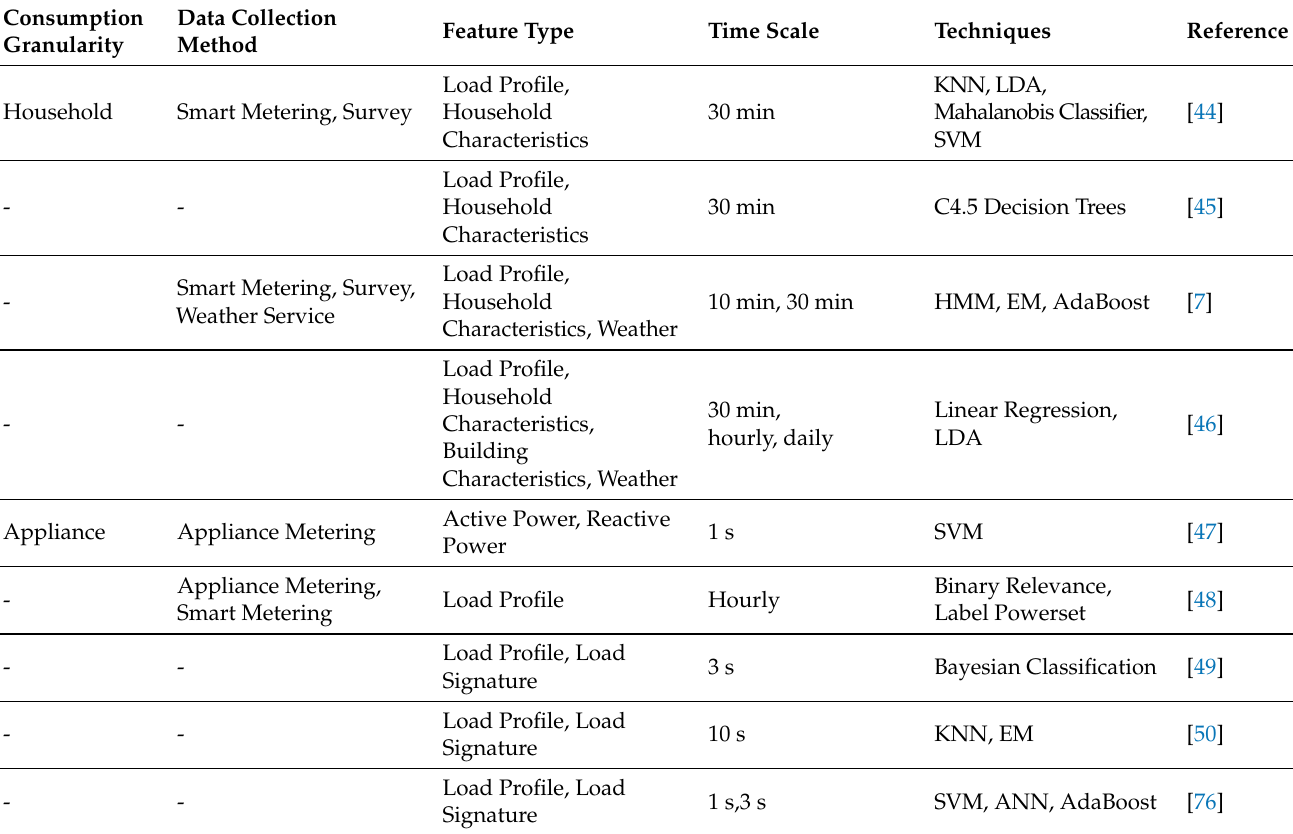
Table 4. A Summary of the reviewed research works on energy